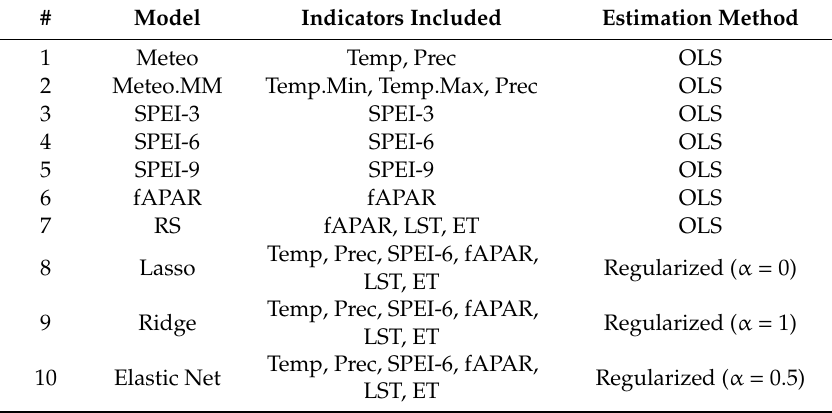
Table 3. Summary of the estimated models: model name identifier, indicators included, and estimation method